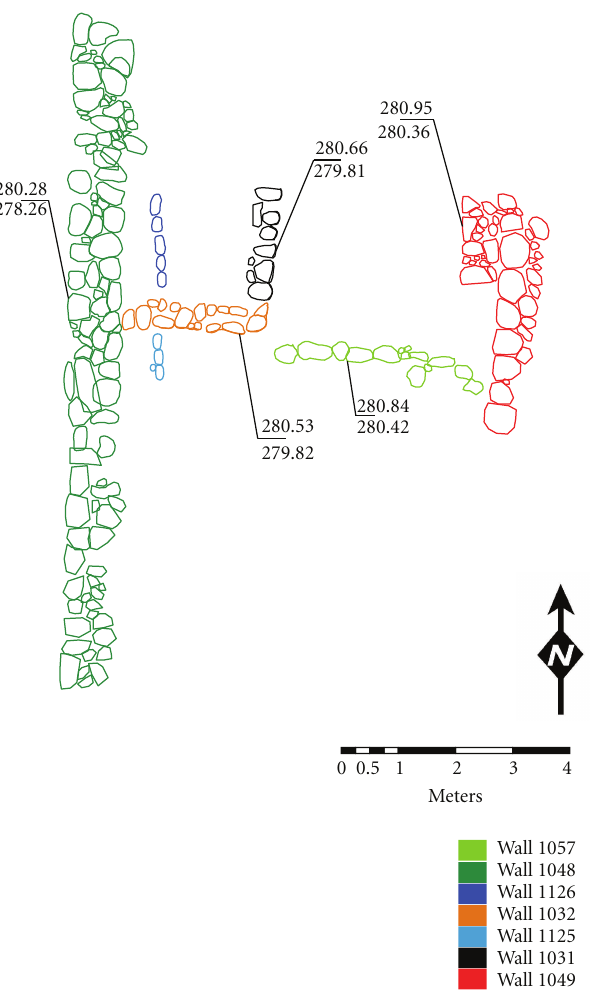
Figure 7: Ground truth, archaeological plan of the excavated walls detected using the 3D ERT